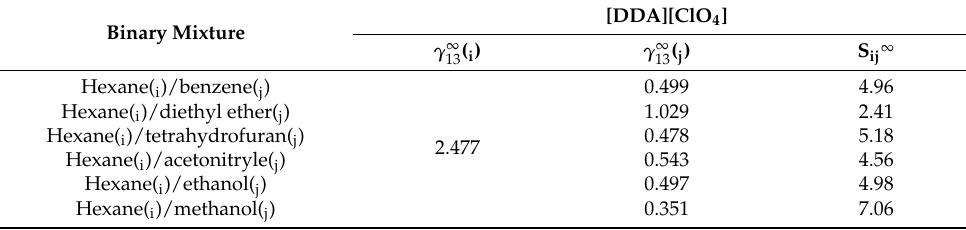
Table 3. The S ∞ values for selected separation systems of [DDA][ClO 4 ] at 50 ◦ C. ij Binary